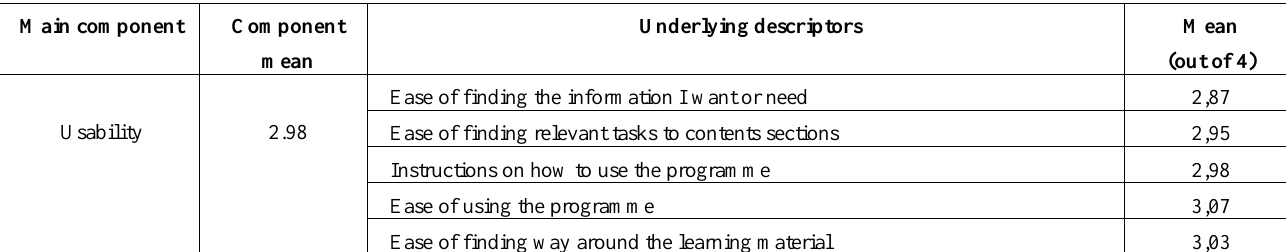
Table 2: Rating of usability of ID model